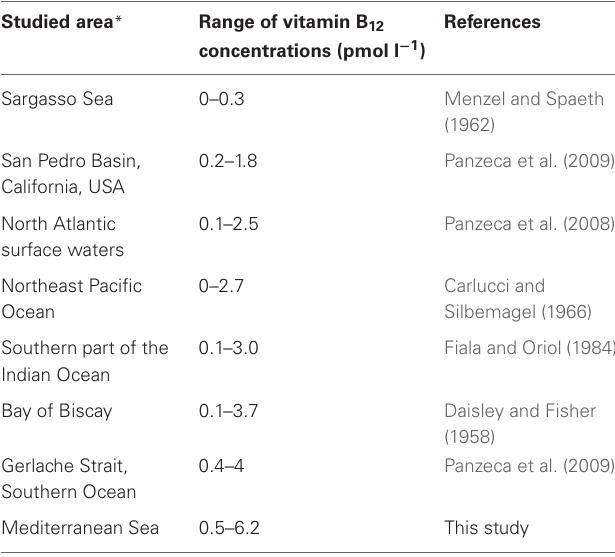
Table 1 | Ranges of vitamin B 12 concentrations reported in different marine areas of the